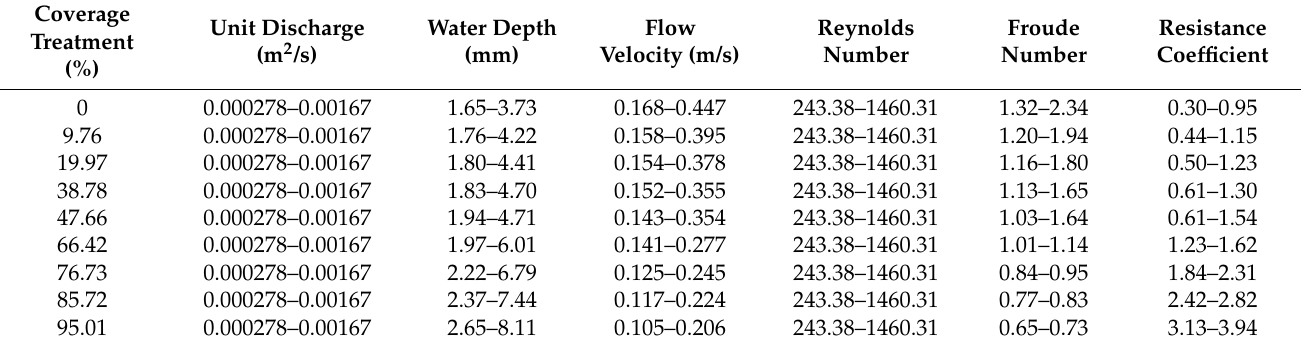
Figure 2. Vegetation coverage density and degree vs. number of grass plants used in this test. Table 1. Ranges of hydraulic parameters for different degrees of vegetation coverage.